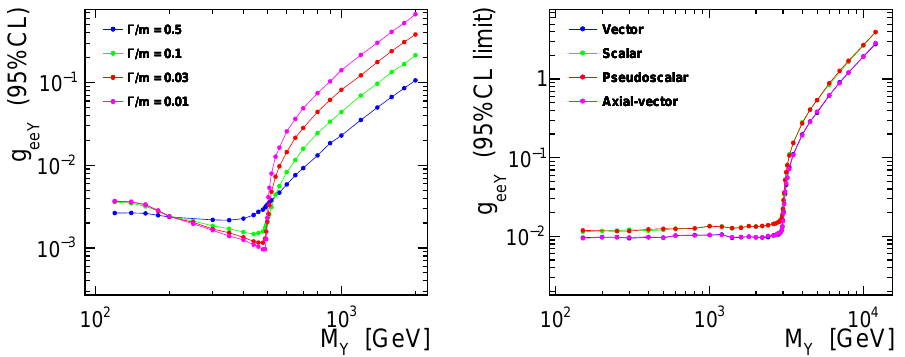
Figure 6: Limits on the mediator coupling to electrons for different relative widths of vector mediator at 500 GeV ILC (left) and for mediator width of Γ / M = 0.03 and different mediator types at 3 TeV CLIC